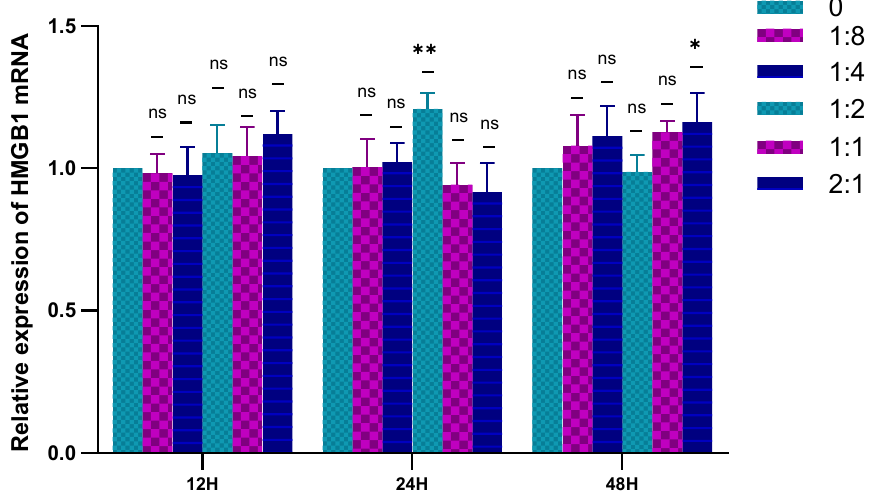
Figure 3. Statistical diagram of relative expression of HMGB1 in HSFs in cell co-culture. ns: p > 0.05, *: p < 0.05, **: p < 0.01.